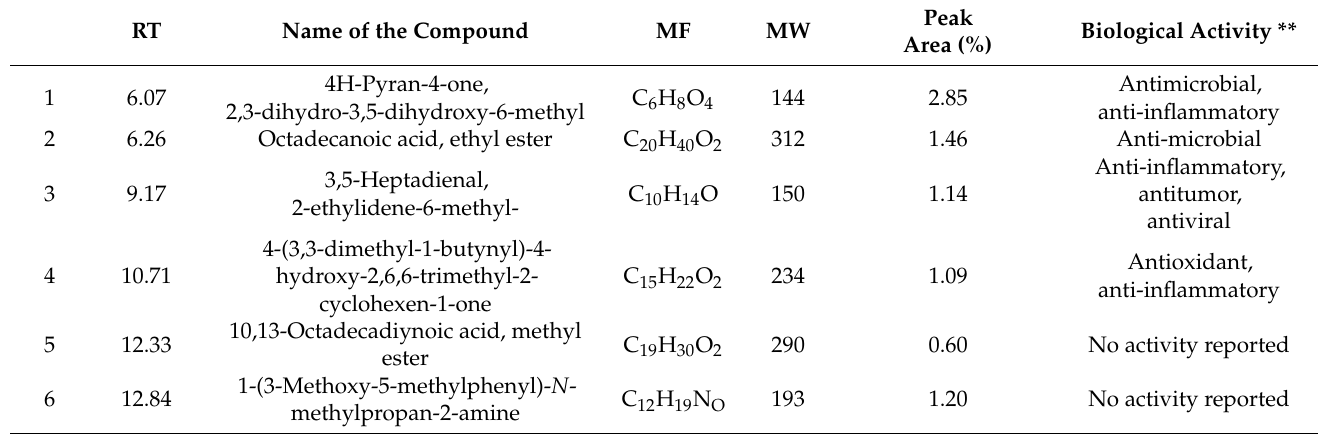
Figure 1. GC-MS chromatogram of the ERF of M. arboreus . Table 3. The identified compounds in the ERF of M. arboreus RF by GC/MS analysis.